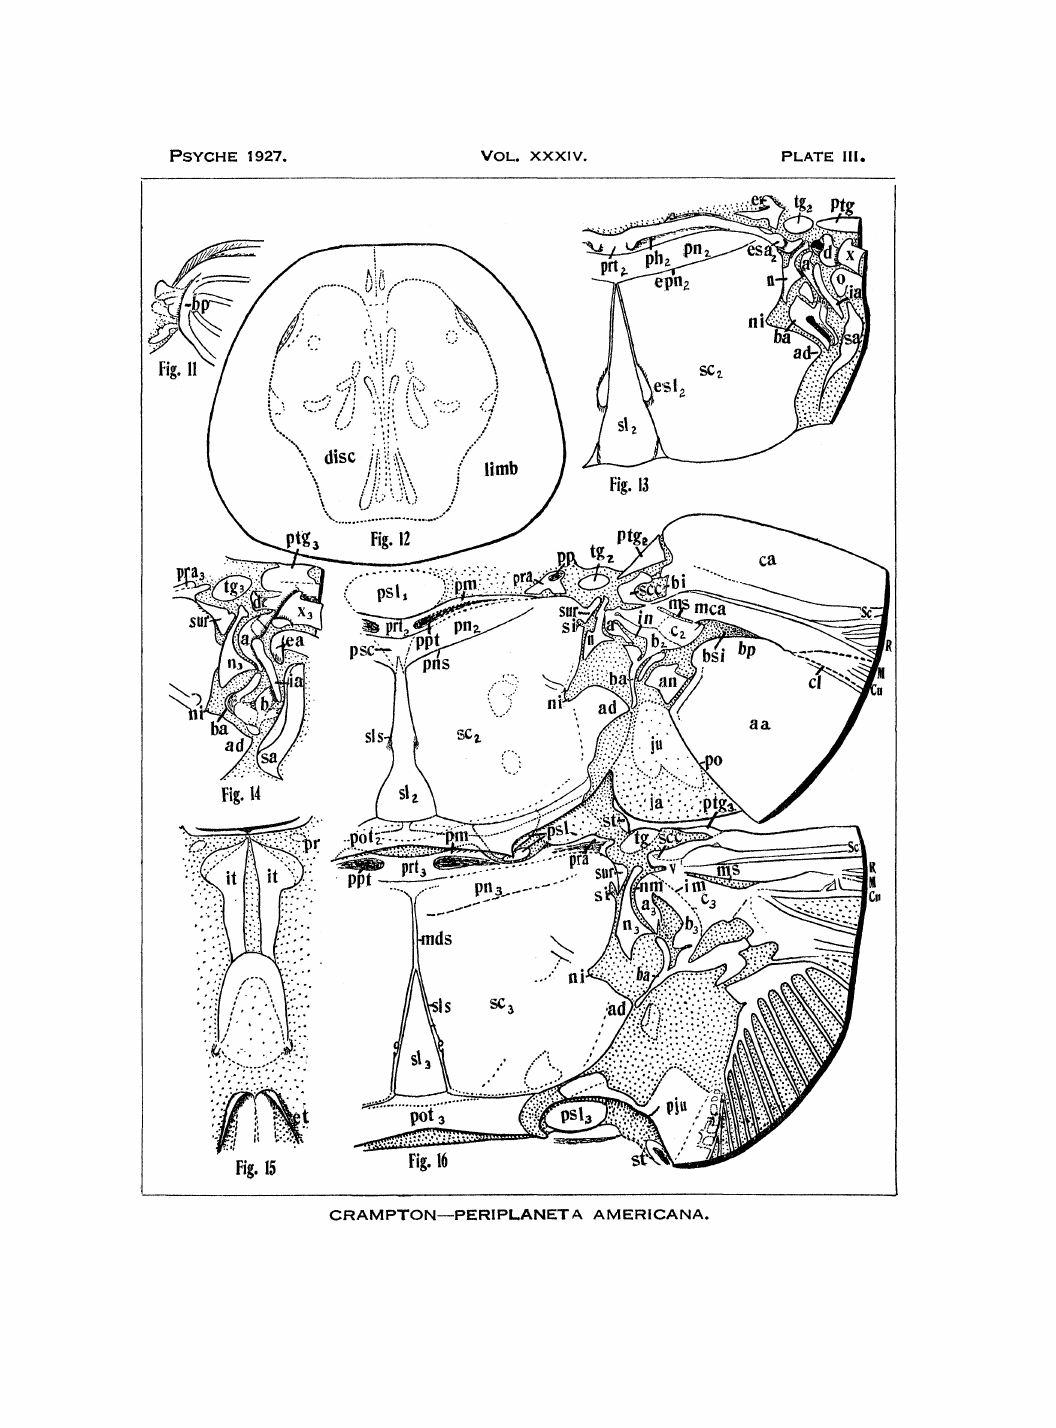
CRAMPTON--PERIPLANET A